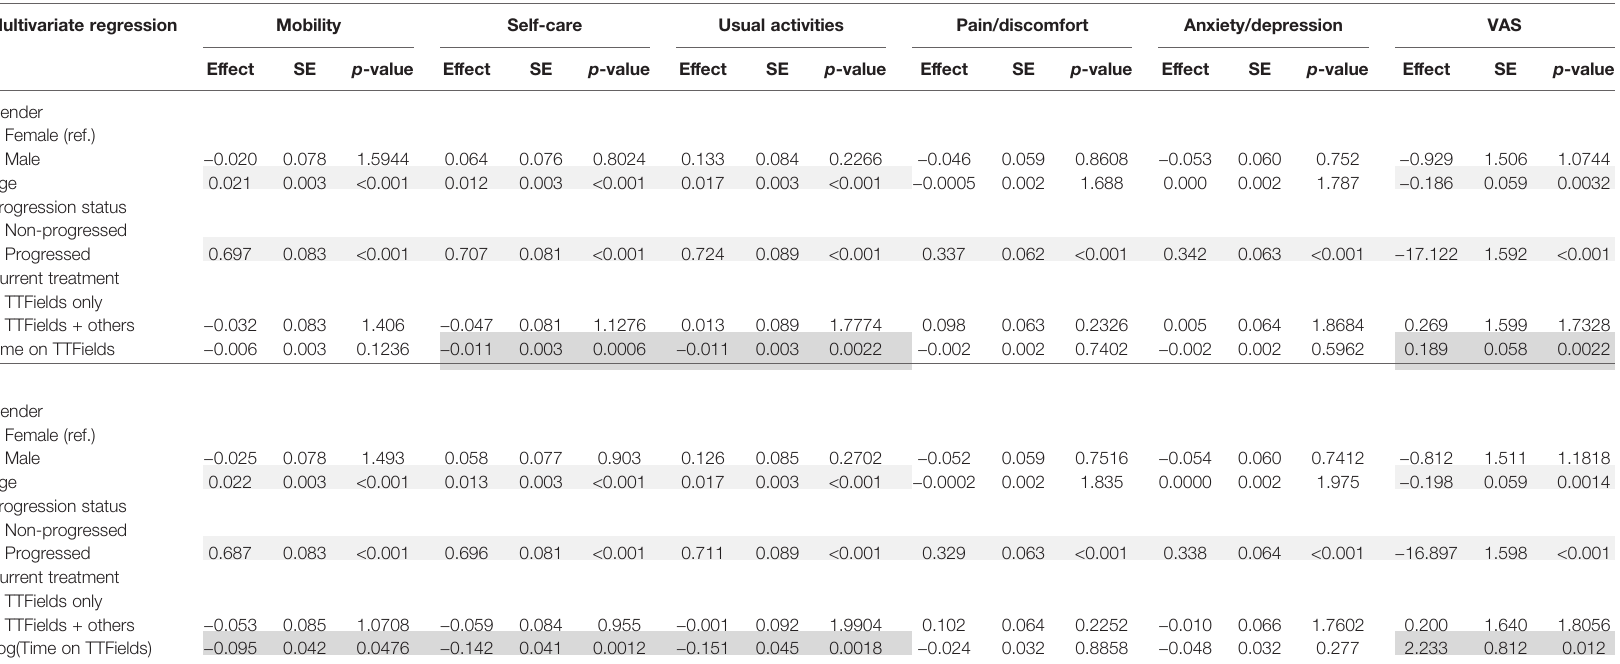
TABLE 5 | Multivariate regression results with time on TTFields. Multivariate regression